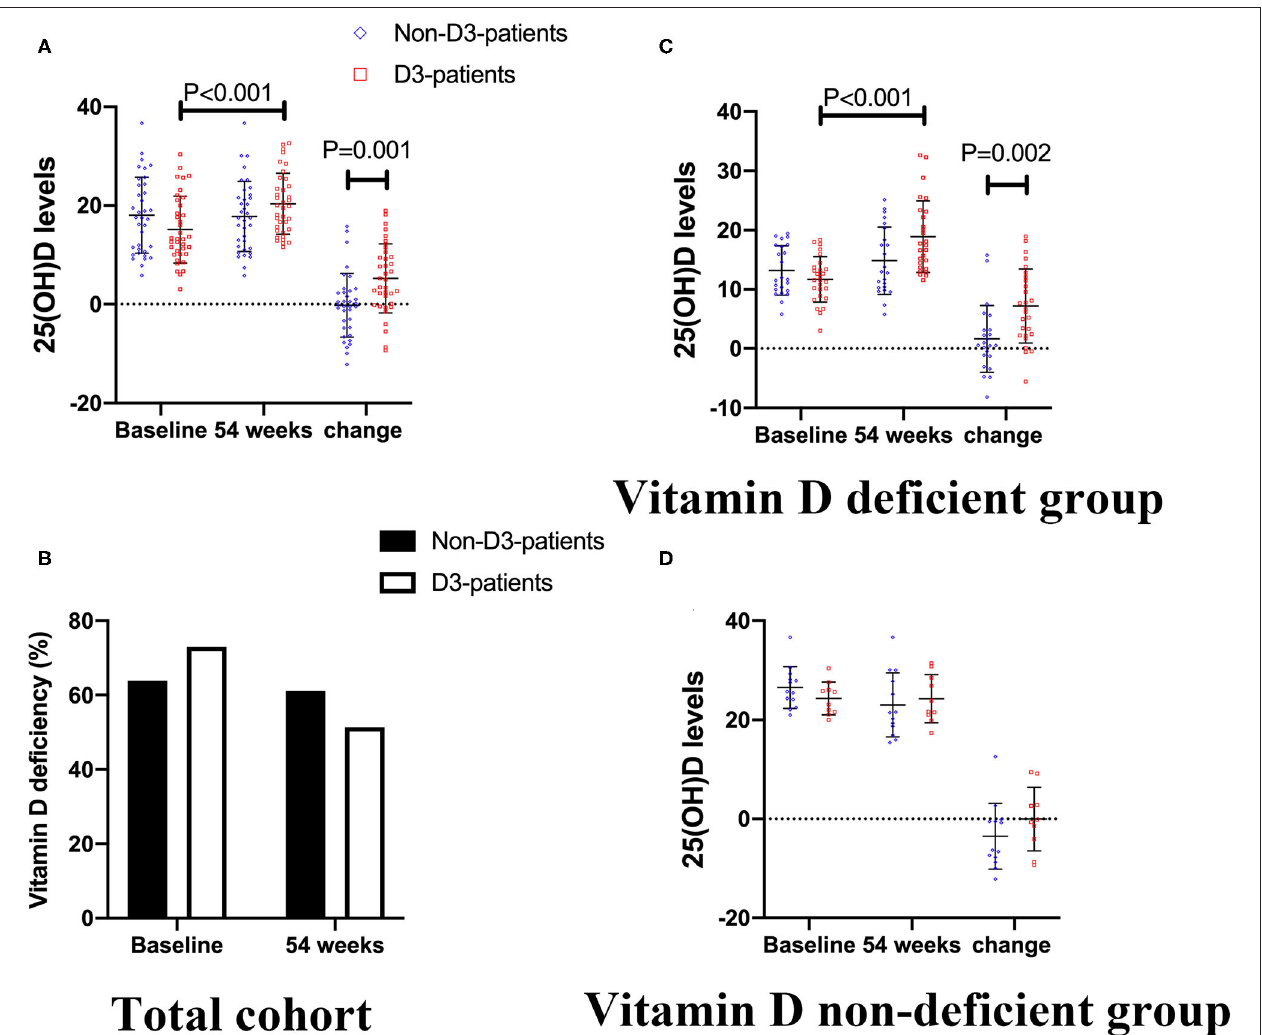
FIGURE 3 | The changes of 25(OH)D levels between baseline and week 54 in CD patients receiving IFX therapy. (A,B) In total cohort. (C) In vitD deficient group. (D) In vitD non-deficient group. vitD3 supplementation after 54-week IFX treatment (week 54